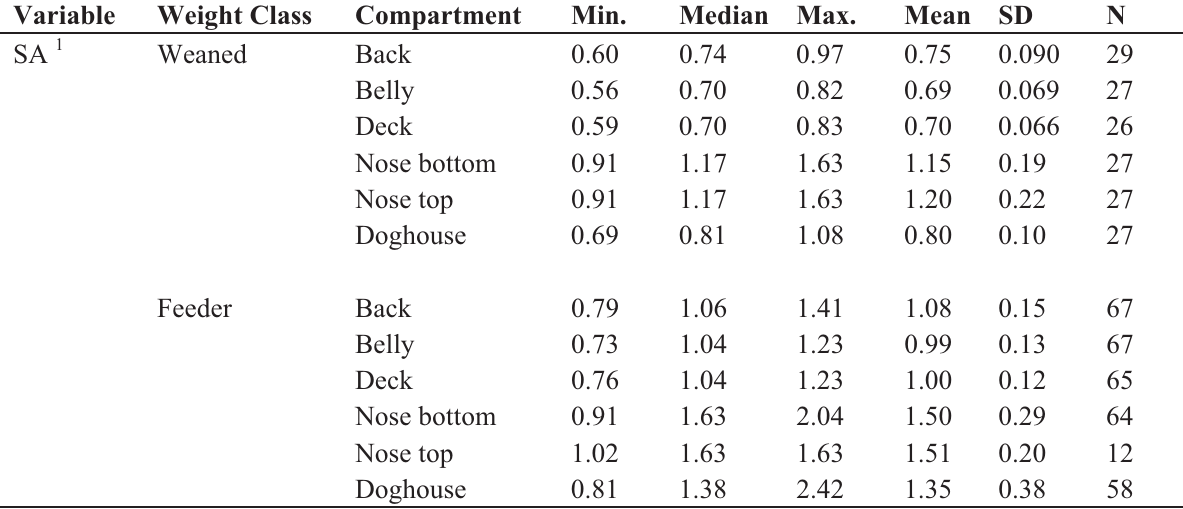
Table 6. Space allowances (m 2 /head) for cattle on tri-axle trailers that were unloaded at feed, water and rest stations near Thunder Bay, ON by weight